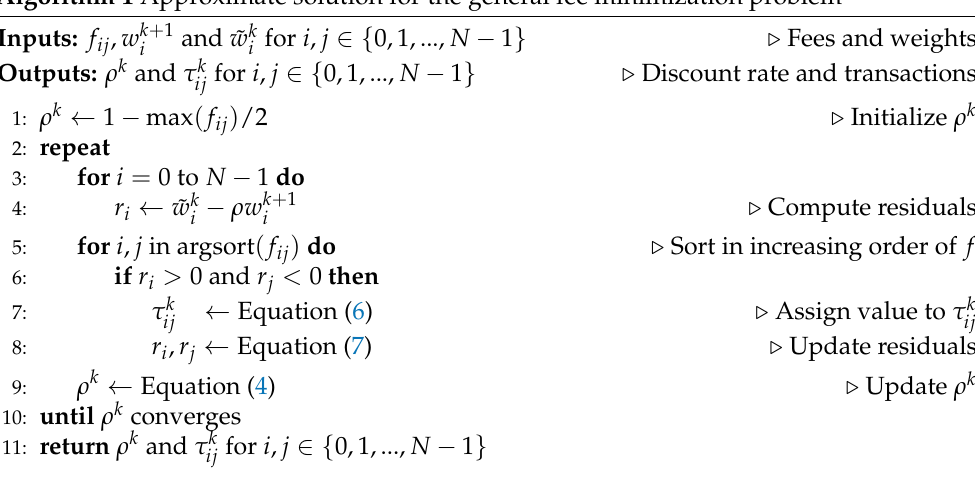
Algorithm 1 Approximate solution for the general fee minimization problem